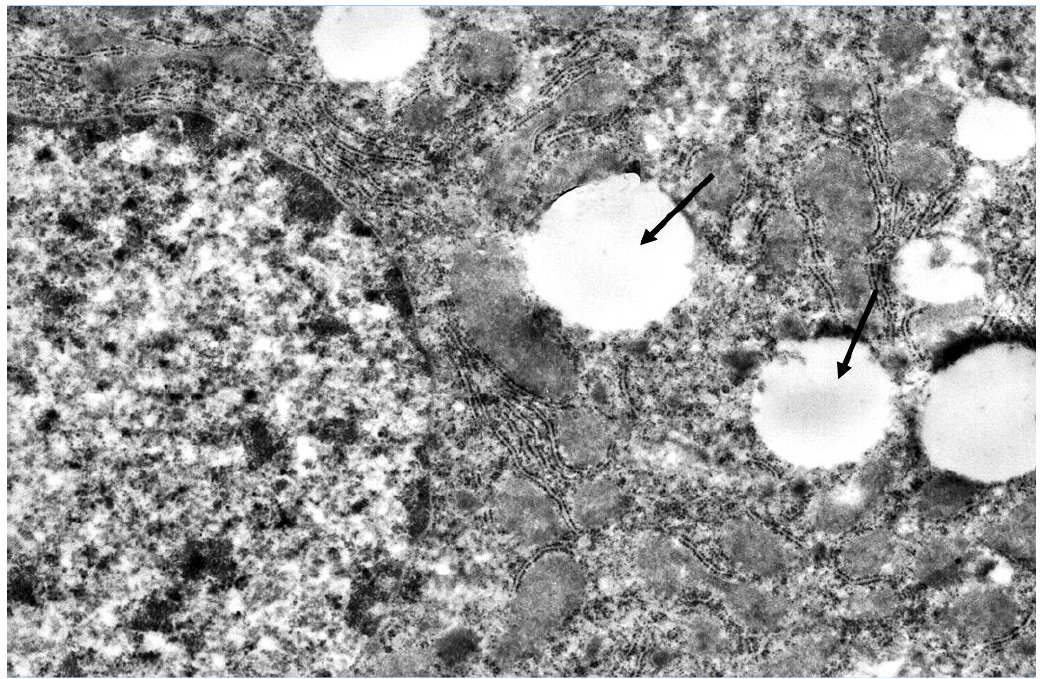
Figure 5. Mild lipid accumulation (arrows) in hepatocyte of mice with acute lipemia pretreated by mannan A. Magnification 6000×.